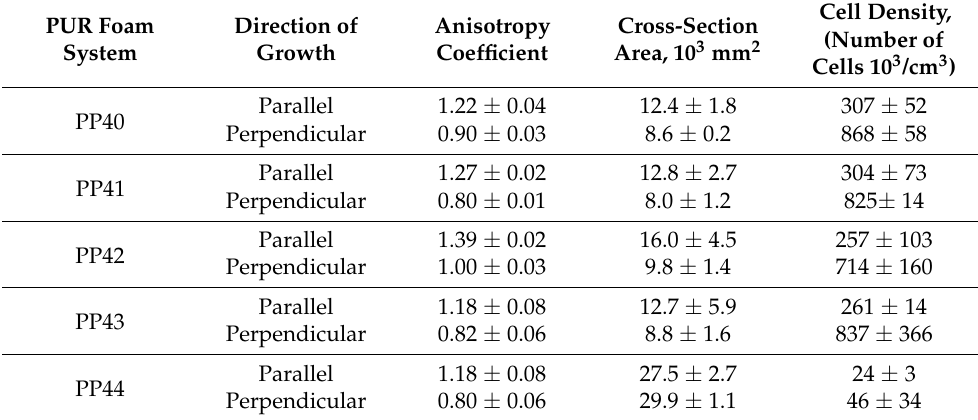
Table 4. Selected cell structure parameters of rigid PUR